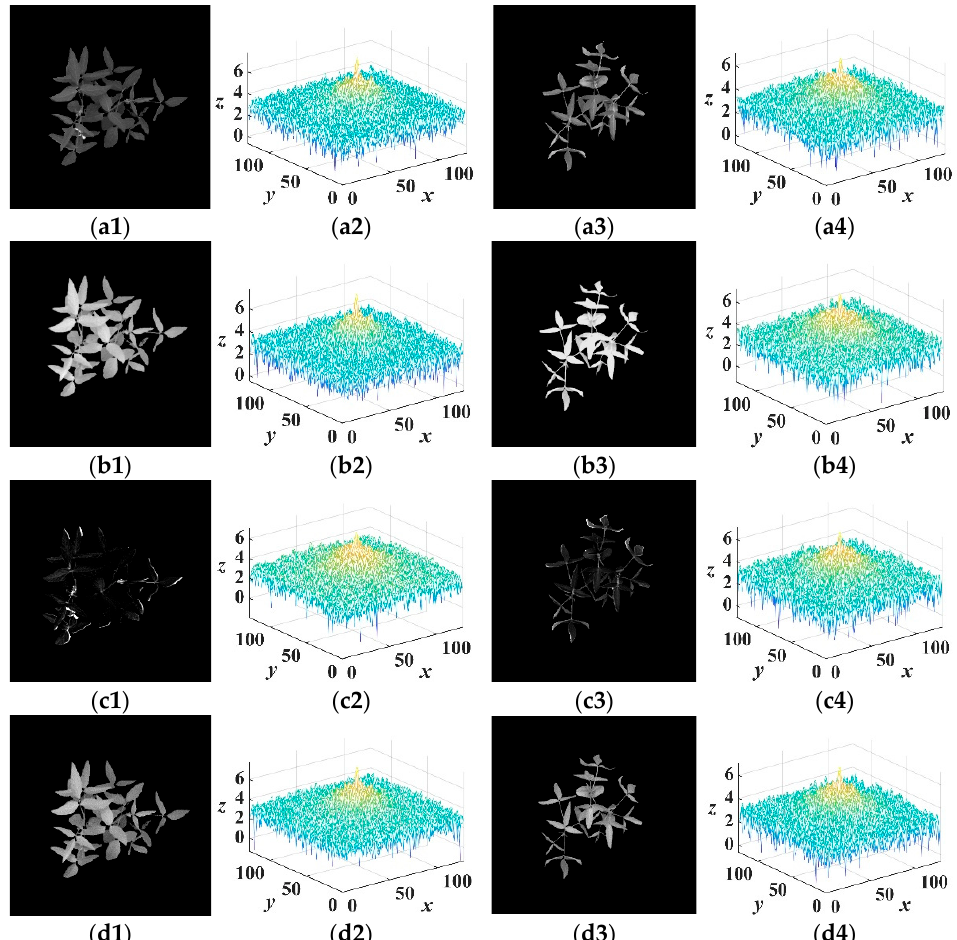
Figure 15. Energy spectrum of the soybean canopy’s multispectral image: ( a1 ) GRE canopy under normal treatment, ( a2 ) GRE energy spectrum under normal treatment, ( a3 ) GRE canopy under drought treatment, ( a4 ) GRE energy spectrum under drought treatment, ( b1 ) NIR canopy under normal treatment, ( b2 ) NIR energy spectrum under normal treatment, ( b3 ) NIR canopy under drought treatment, ( b4 ) NIR energy spectrum under drought treatment, ( c1 ) RED canopy under normal treatment, ( c2 ) RED energy spectrum under normal treatment, ( c3 ) RED canopy under drought treatment, ( c4 ) RED energy spectrum under drought treatment, ( d1 ) REG canopy under normal treatment, ( d2 ) REG energy spectrum under normal treatment, ( d3 ) REG canopy under drought treatment and ( d4 ) REG energy spectrum under drought treatment.